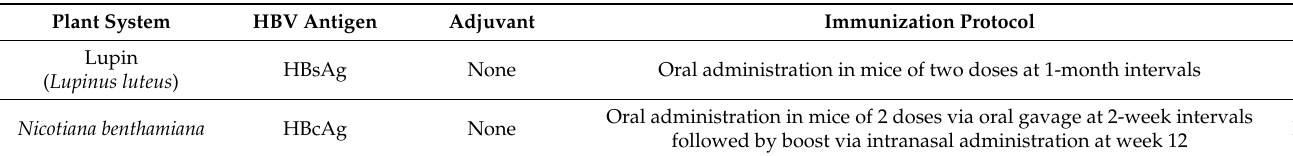
Table 1. Oral HBV plant vaccines with proven immune